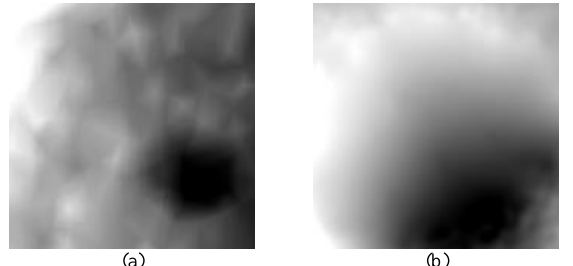
Figure 7. DEMs of resolutions 0.05m,0.02m with different